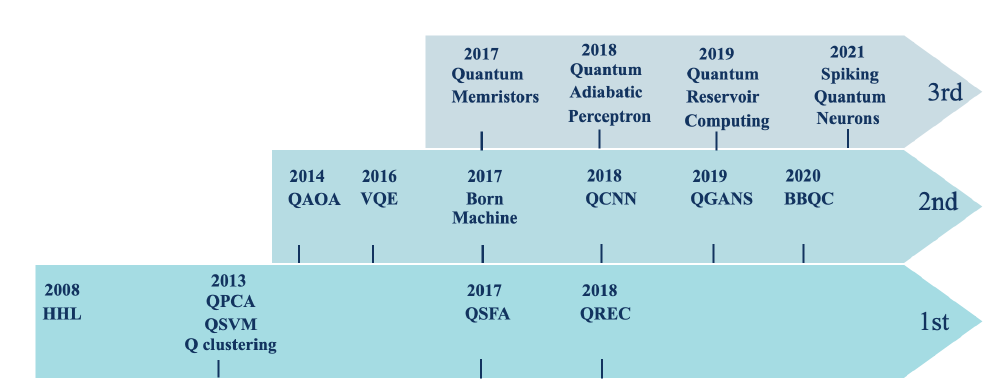
Figure 3. One can consider three different domains in the history of quantum machine learning development. The first domain was formed by the Harrow-Hassidim-Lloyd (HHL) algorithm in 2008, harnessing quantum computer for enhancement in linear algebra compu- tation, while algorithms in the second domain tend to adapt a hybrid approach leveraging on some parameterized quantum circuits. And the third domain, which uses inherent in- teraction and the dynamics of a quantum system as a direct resource of learning trying to mimic brain-like